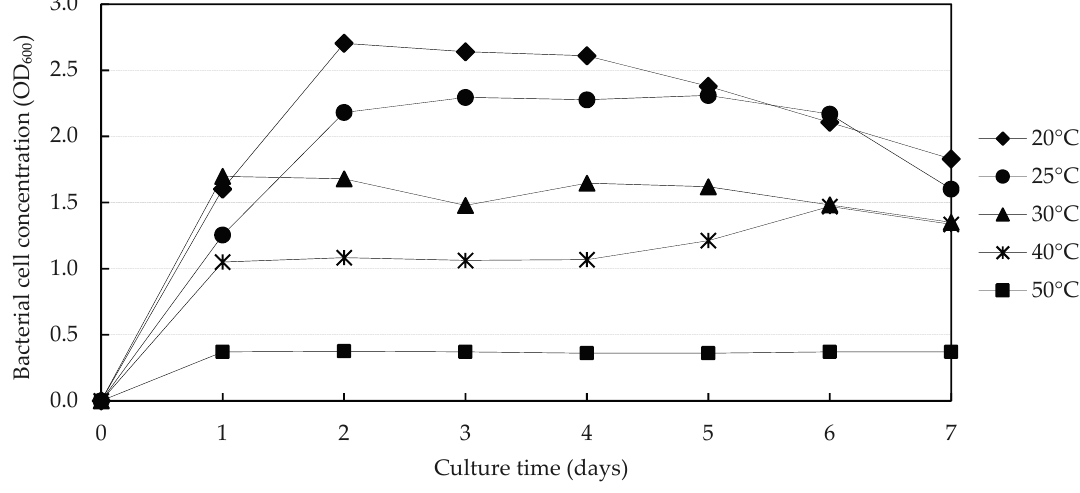
Figure 4. Variation of bacterial cell concentration of Sporosarcina sp. at different temperatures.